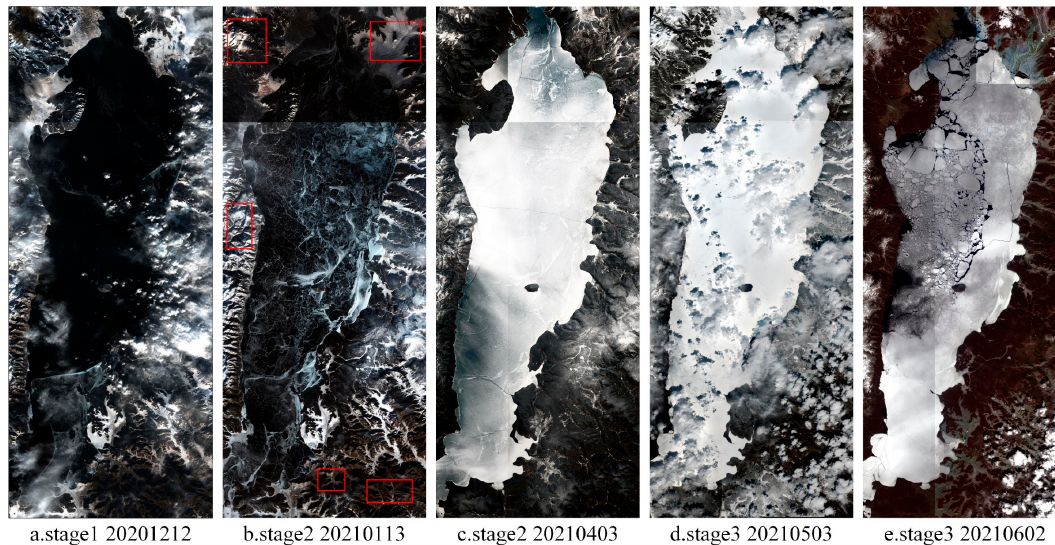
Figure 11. True color images of Lake Khovsgol at different times (B4, B3, B2). ( a ) shows that the lake started to freeze from the south, while the north remained water. ( b ) shows that the ice cover has completely covered the whole lake and the ice ridges/mounds are clearly visible. The red area is the selected stable area. ( c ) shows the intense solar radiation on the lake surface in April, which formed bubbles and air channels on the ice surface, giving the ice a white, snow-like appearance. ( d ) shows an example of the third phase obscured by clouds. ( e ) shows the lake ice breaking up from the north.